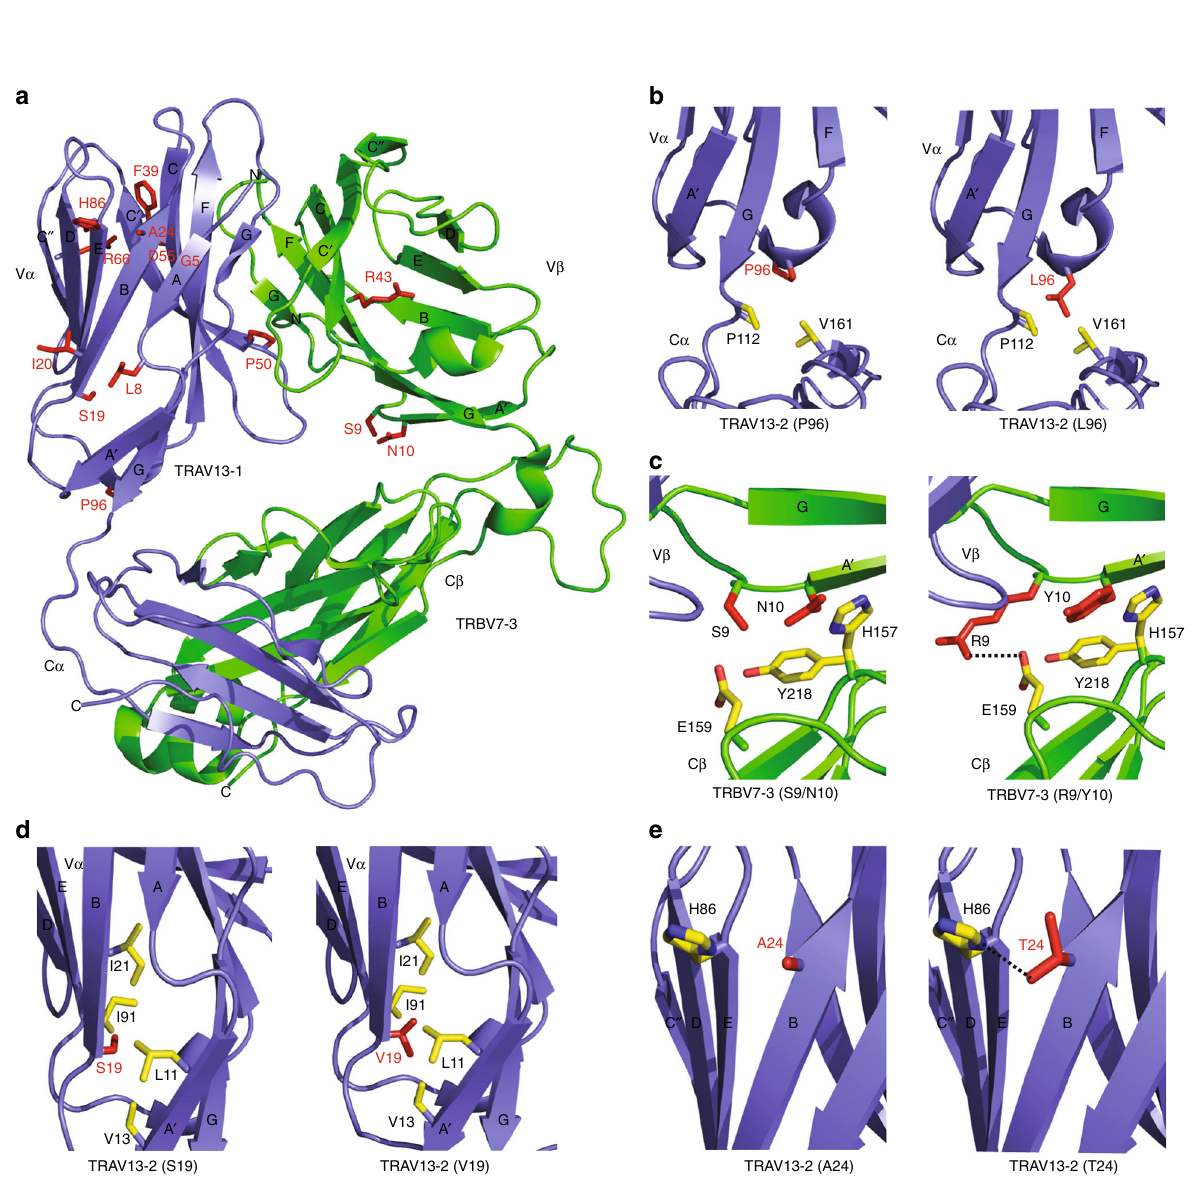
Fig. 5 Structural modeling reveals a mechanistic role for framework residues in TCR stability. The published 3D structure of the 3PL6 TCR (TRAV13-1/ TRBV7-3) was used as a model for the weak 1 TCR (TRAV13-2/TRBV7-3). a The location of each of the 14 residues that were changed in the weak 1 TCR to modify surface expression. b The change from P96 α to L96 α improves the interaction between the variable and constant domains of the α chain. Left panel: proline at position 96. Right panel: leucine at position 96. c The change from S9 β and N10 β to R9 β and Y10 β improves the interaction between the variable and constant domains of the β chain. Left panel: serine and asparagine at positions 9 and 10, respectively. Right panel: arginine and tyrosine at positions 9 and 10, respectively. d The change from S19 α to V19 α improves hydrophobic interactions within a hydrophobic core in the α chain. Left panel: serine at position 19. Right panel: valine at position 19. e The change from A24 α to T24 α can improve hydrogen bond interactions with the imidazole ring nitrogen of H86 α . Left panel: alanine at position 24. Right panel: threonine at position 24. V α variable alpha, V β variable beta, C α constant alpha, C β constant